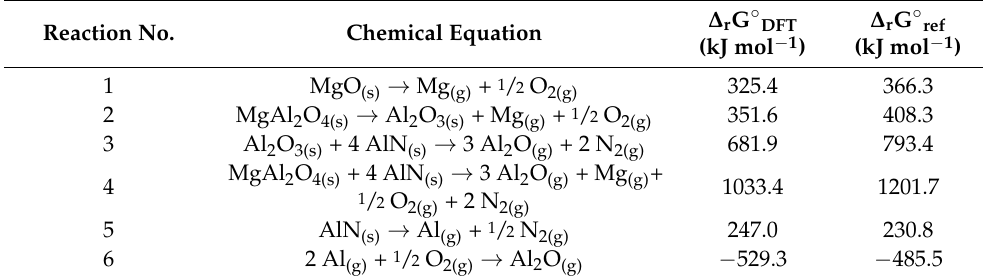
Table 2. The standard Gibbs energies of reaction ∆ r G ◦ at 1500 ◦ C and 1 bar, calculated using DFT and compared to experimental references